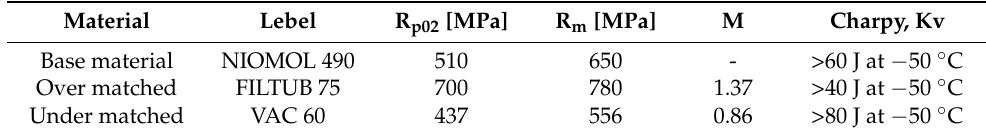
Table 2. Tensile mechanical properties.